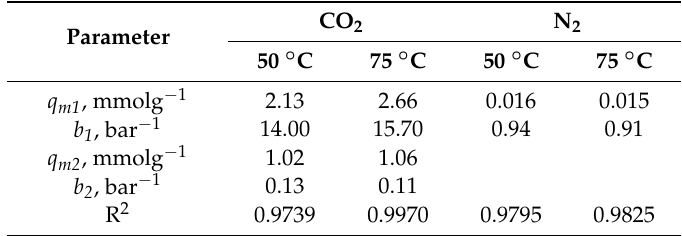
Table 5. Fitting parameters to the experimental data for MSG20I30 at 50 ◦ C and 75 ◦ C.